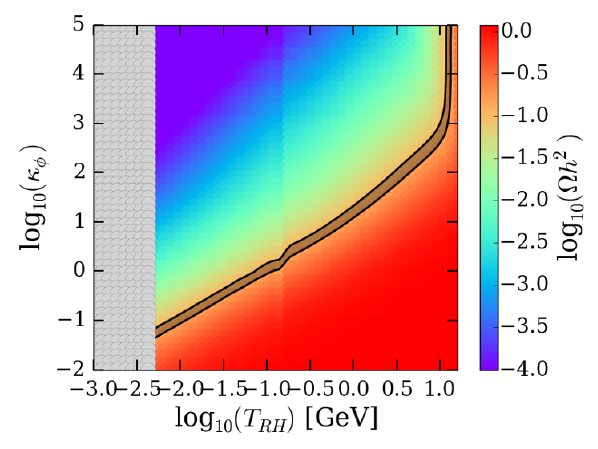
Figure 2. The relic density log ((cid:10) h 2 ) of Point A, indicated by the colour code in the legend, as a 10 function of T RH and (cid:20) (cid:30) . Parameter sets consistent with the Planck constraints lie along the darker shaded strip. The grey zone at small T RH is excluded by BBN